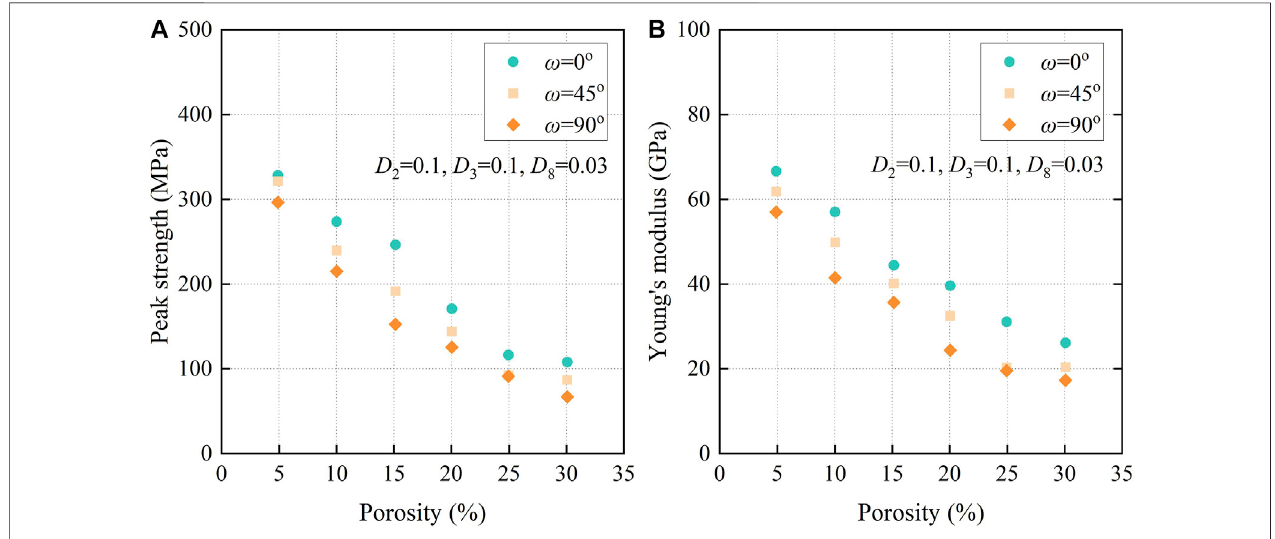
FIGURE 7 | Results of (A) compressive peak strength; and (B) corresponding Young ’ s modulus for groups P-A-1, P-A-2, and P-A-3.